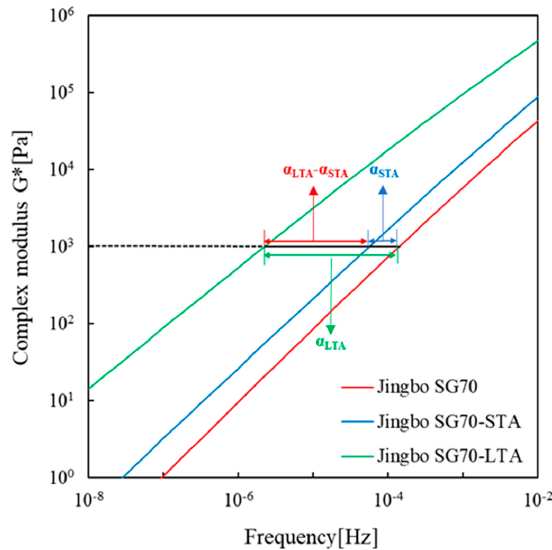
Figure 4. Schematic diagram of the horizontal shift factor with a reference complex modulus at 1000 Pa.